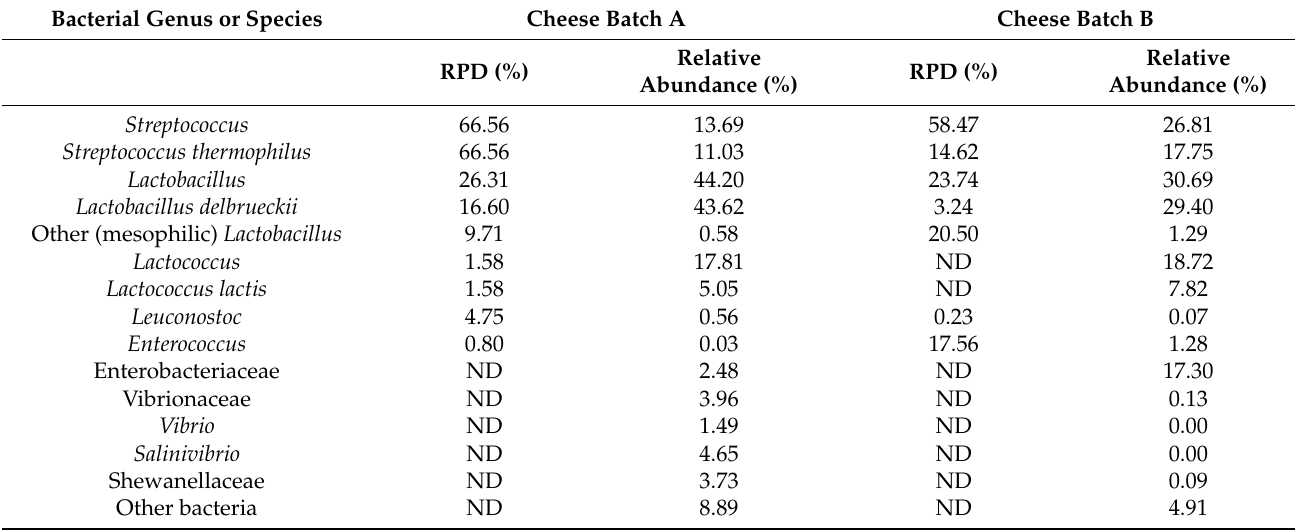
Table 7. Prevalence of the main bacterial genera and species in the two retail RTE Galotyri-like acid-curd cheese batches based on their relative abundances of detected OTUs versus their relative population density (RPD) values calculated on the basis of microbial enumeration